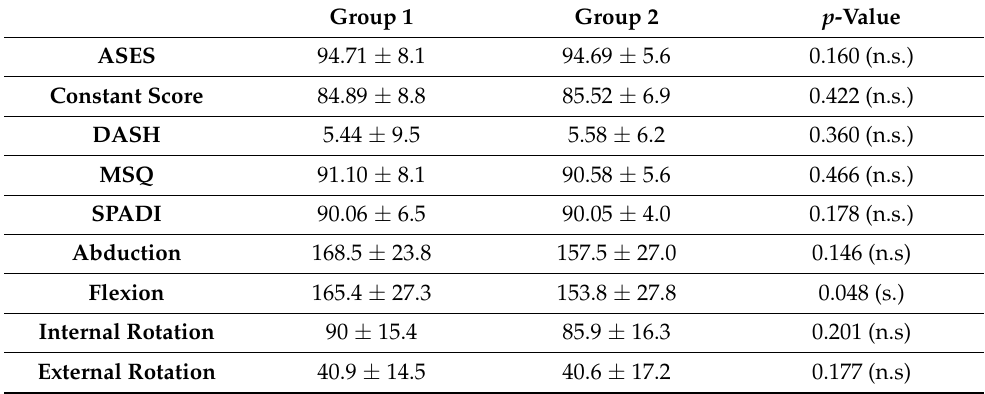
Table 1. Comparison of the functional outcome one year postoperative after arthroscopic assisted ORIF of unstable/displaced lateral clavicle